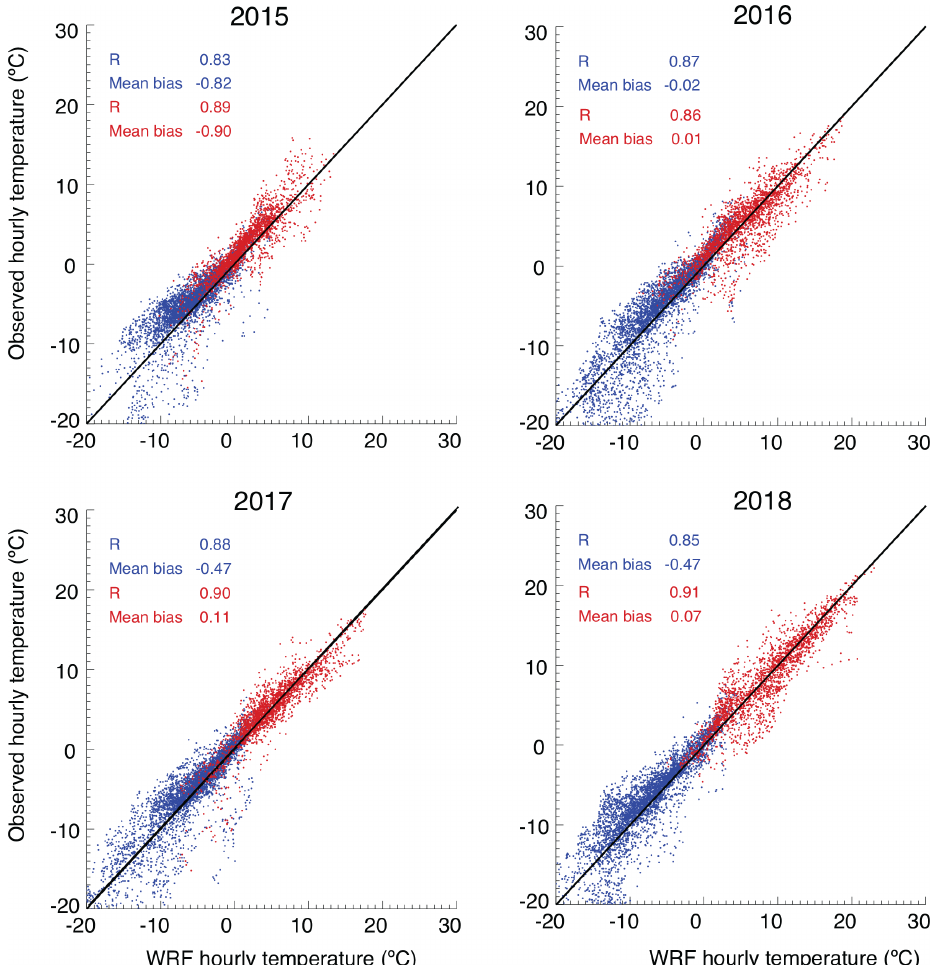
Figure 6. Scatterplot of observed and simulated temperature for mass balance years 2015–2018 at Finse station. Blue represents the winter season, and red represents the summer season.